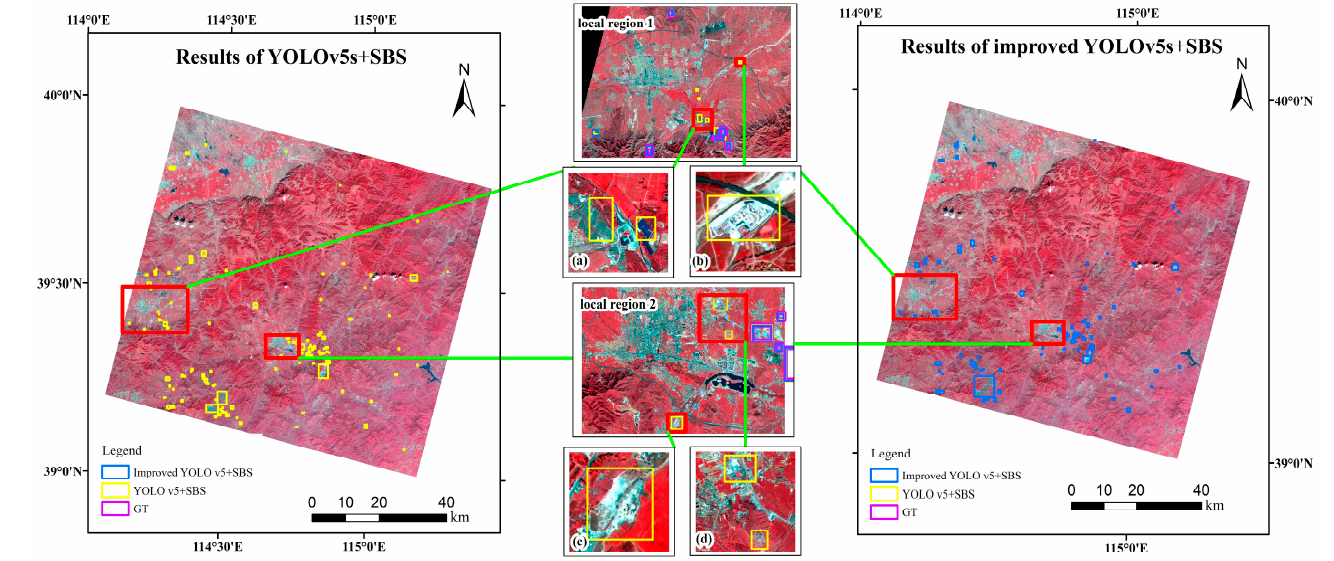
Figure 15. The qualitative results of YOLOv5s+SBS and improved YOLOv5s+SBS on the entire GF-6 images. The yellow detection frames are the detection result of YOLOv5s+SBS, the blue detection frames are the detection result of improved YOLOv5s+SBS, and the purple label frames are the ground truth.